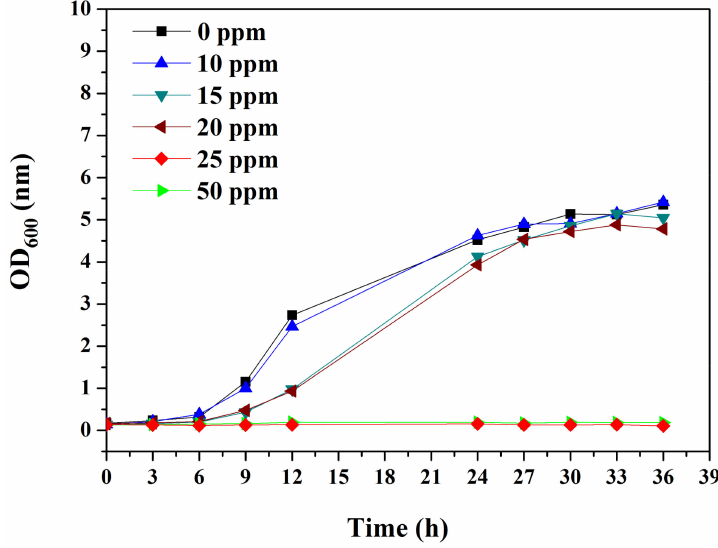
Figure 1. Effects of BDMDAC concentration on the growth curve of D. desulfuricans as a function of time in hours.